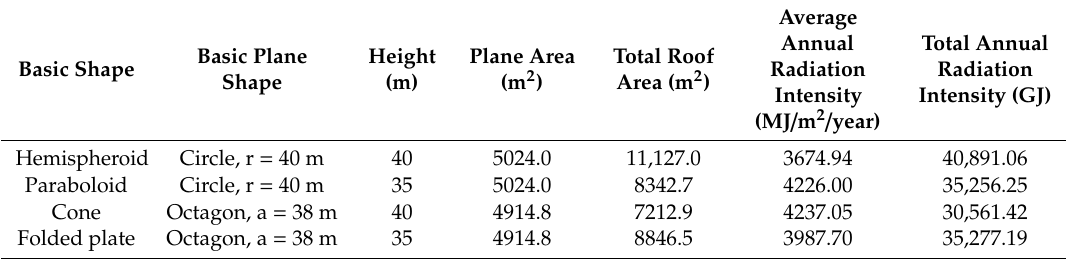
Table 2. Structural parameters of the building and annual radiation intensity of its